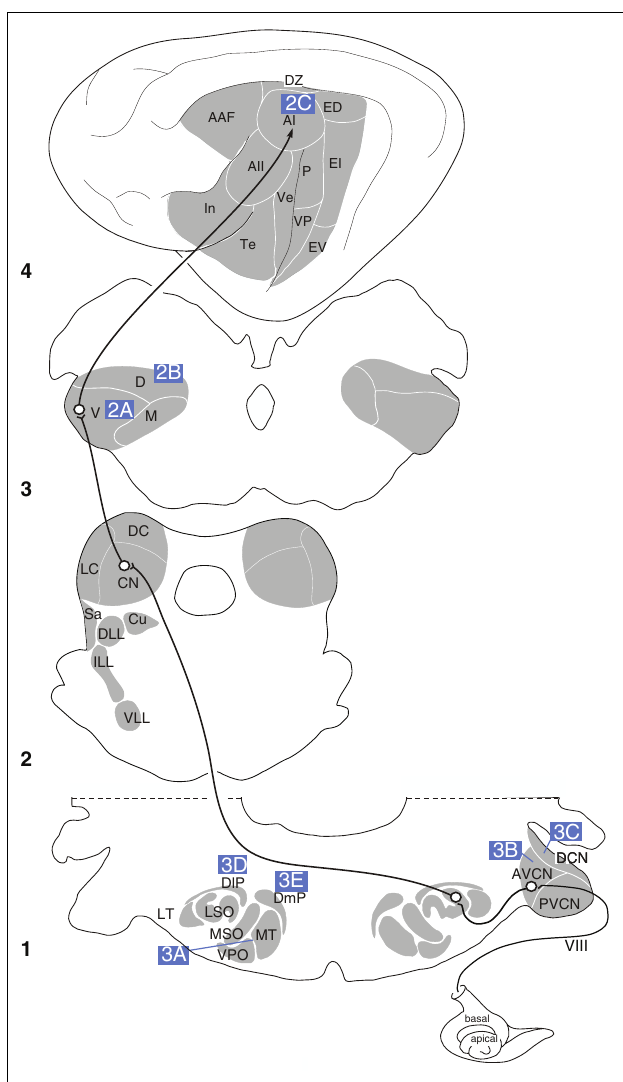
FIGURE 1 |The central auditory pathway. Key nuclei in the feline auditory system and elements of the lemniscal pathway from the medulla (1), midbrain (2), thalamus (3), and auditory cortex (4). Letters in blue boxes indicate the pathways depicted in Figures 2 and 3